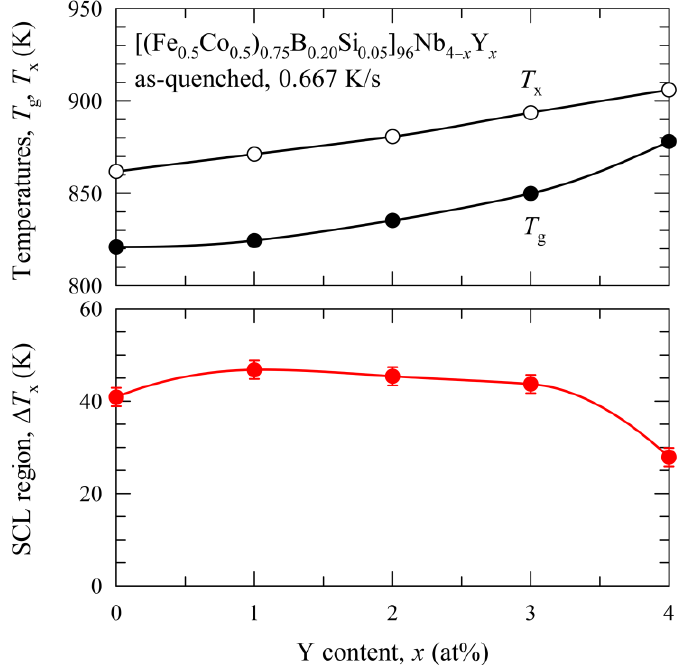
Figure 2. Glass-transition temperature ( T g ), crystallization temperature ( T x ) and supercooled liquid (SCL) region (Δ T x = T x − T g ) of [(Fe 0.5 Co 0.5 ) 0.75 B 0.20 Si 0.05 ] 96 Nb 4− x Y x alloys as a function of Y